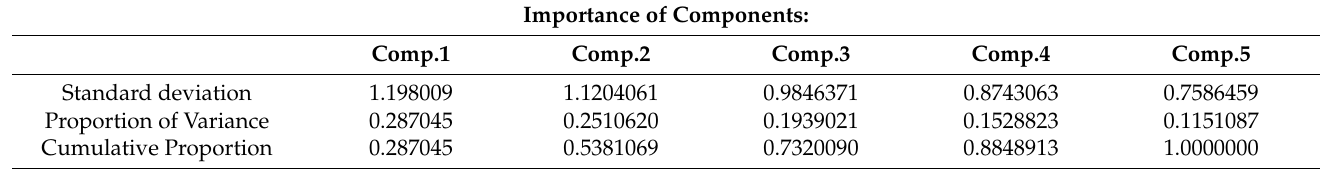
Figure 3. Eigenvalues of the correlation matrix R π . Table 5. The PCA results calculated using the R program are as follows. Importance of